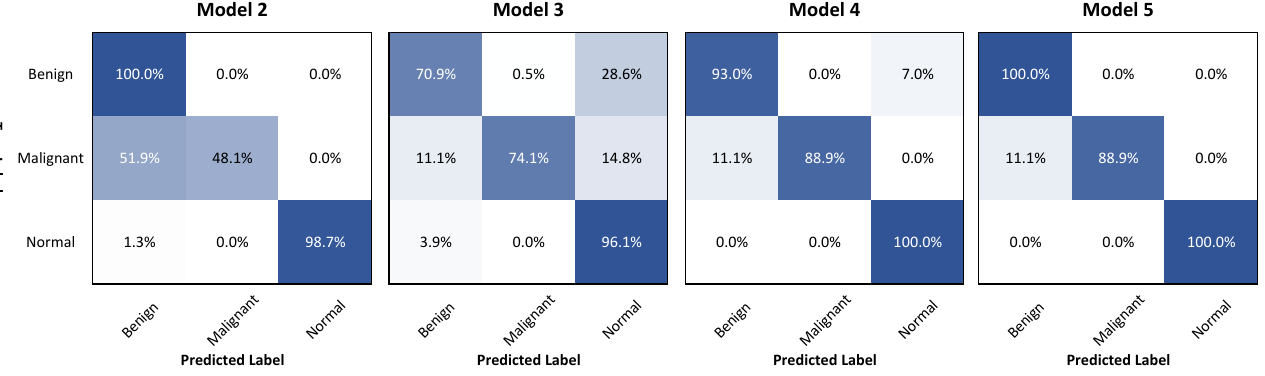
Figure 14. Confusion matrices of four models used in the classification experiment.